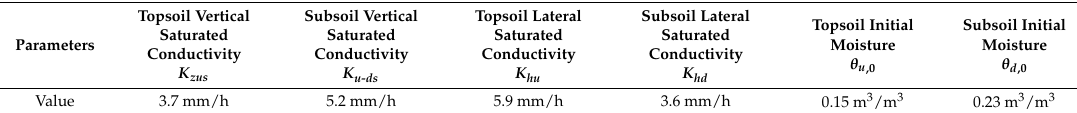
Table 3. Key parameters of the model after